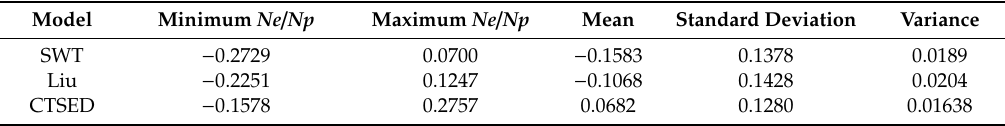
Figure 9. Probability density functions of the SWT, Liu and the cumulative total strain energy density (CTSED) model. Table 6. Statistical parameters computed from the E N values for the three models.